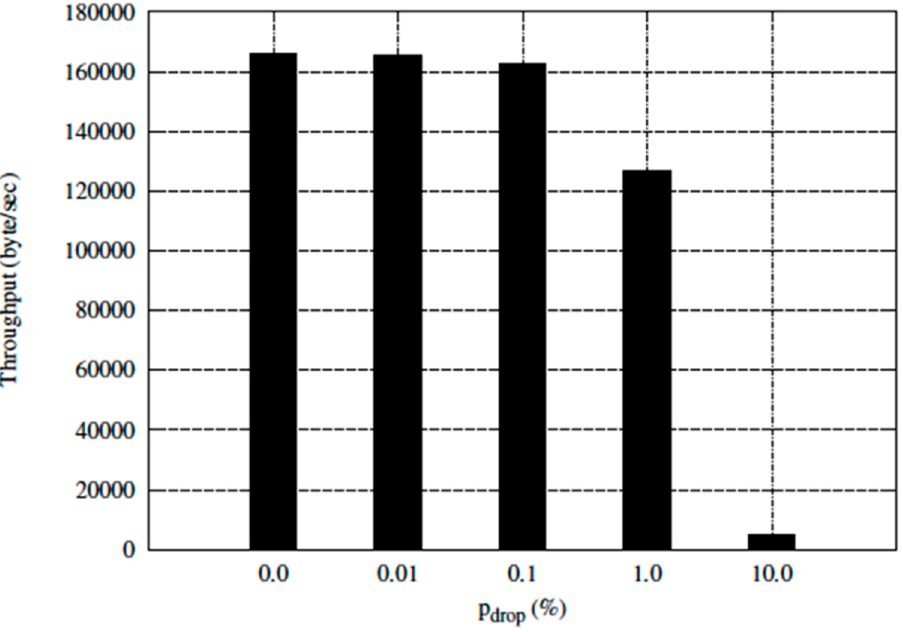
Figure 6. Average FTP Throughput for various probabilities of packet dropping.